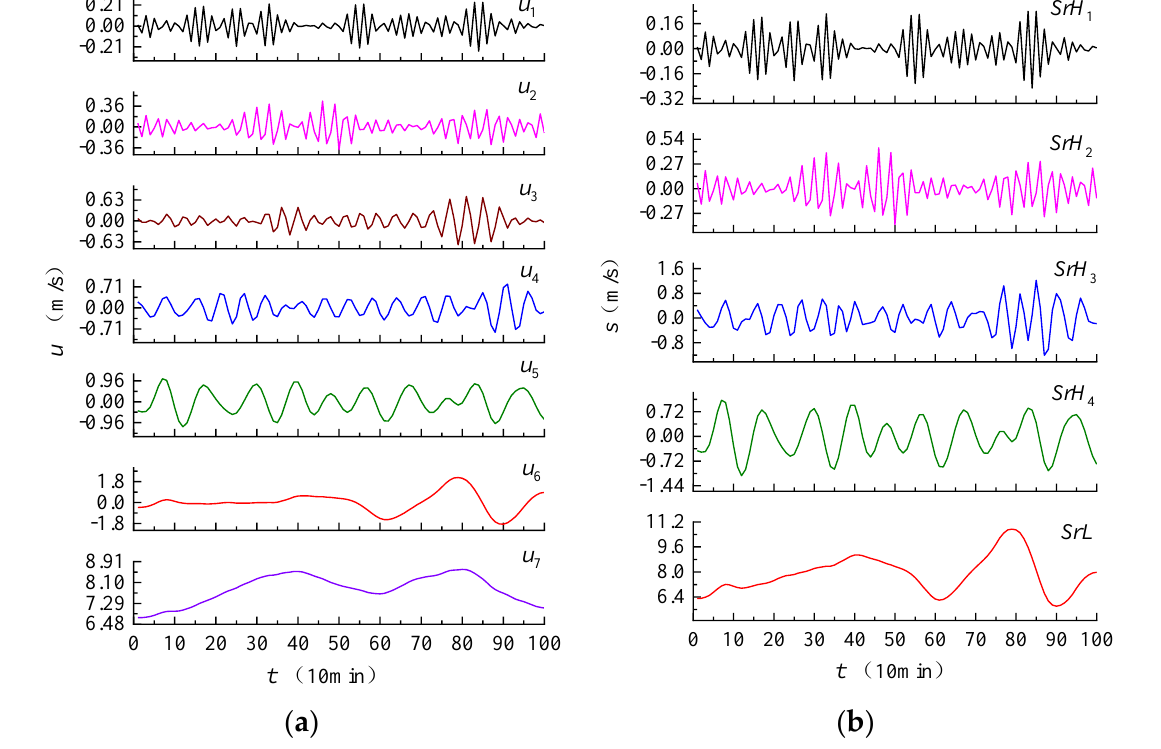
Figure 13. Decomposition result of the first 100 points in the wind speed series: ( a ) result of EVMD and ( b ) result of subseries reconstruction.